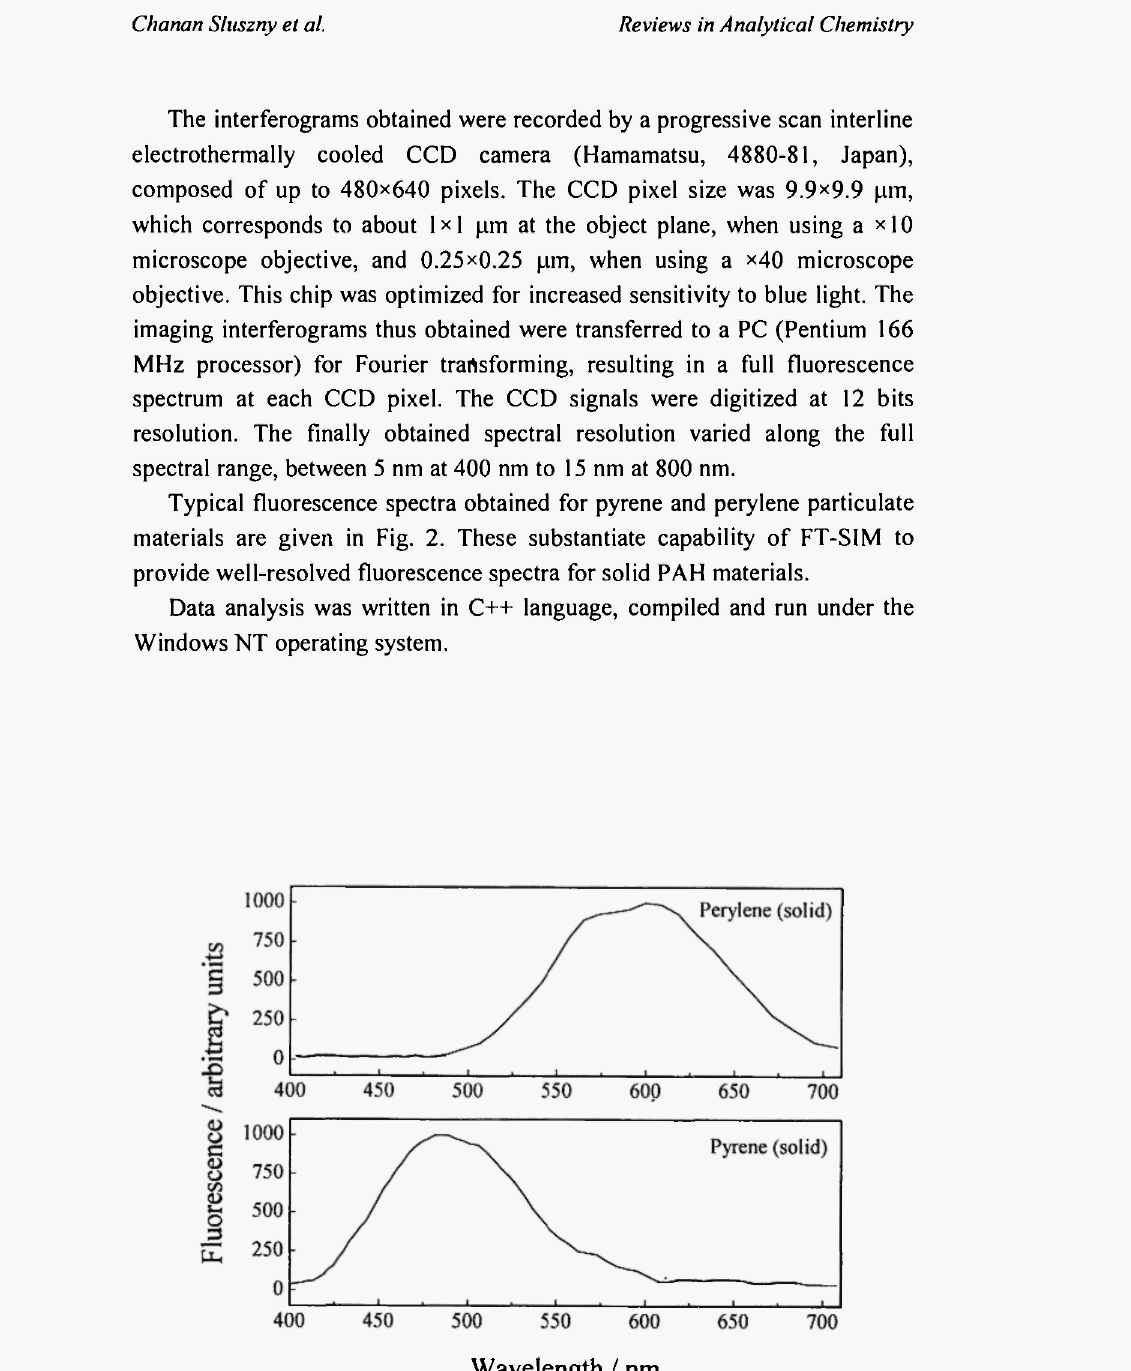
Fig. 2: Crystallyte fluorescence spectra of pyrene and